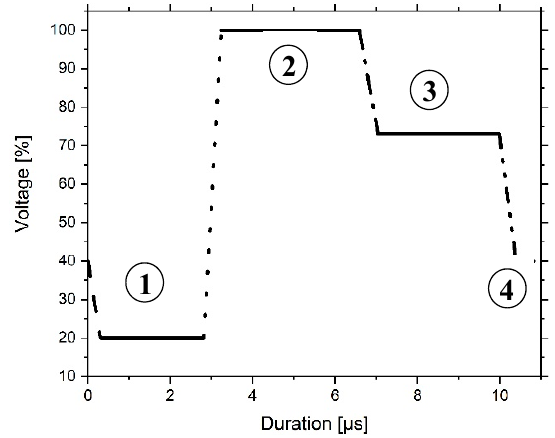
Figure 2. Waveform for the printing of the unmodified and ceramic-filled inks with four subdivided phases.